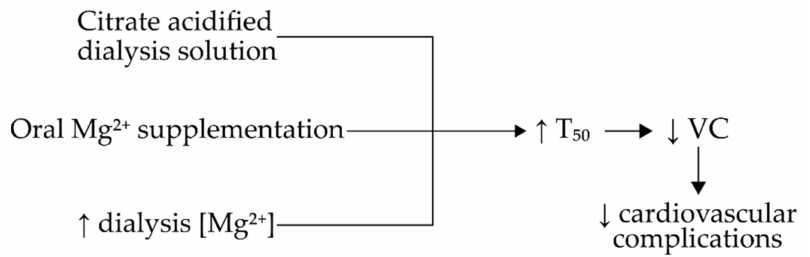
Figure 4. Summary of factors that increase T 50 in CKD patients. Abbreviations: Mg, magnesium; VC, vascular